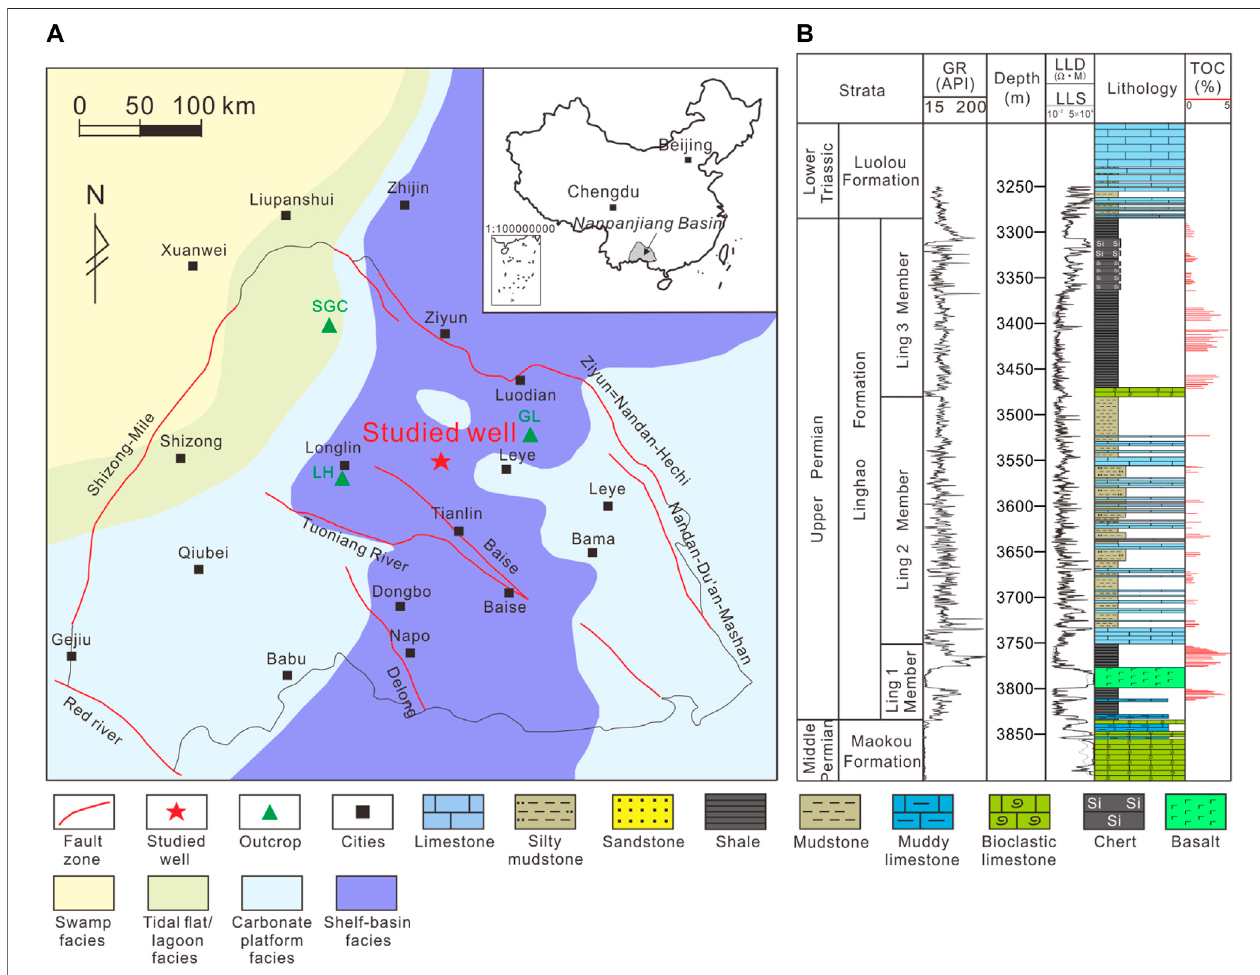
FIGURE 1 | (A) Location of the Nanpanjiang Basin, Southwest China (modi fi ed from Xia et al., 2018). (B) Generalized stratigraphy of Upper Permian Linghao Formation in the study area (based on the studied well).